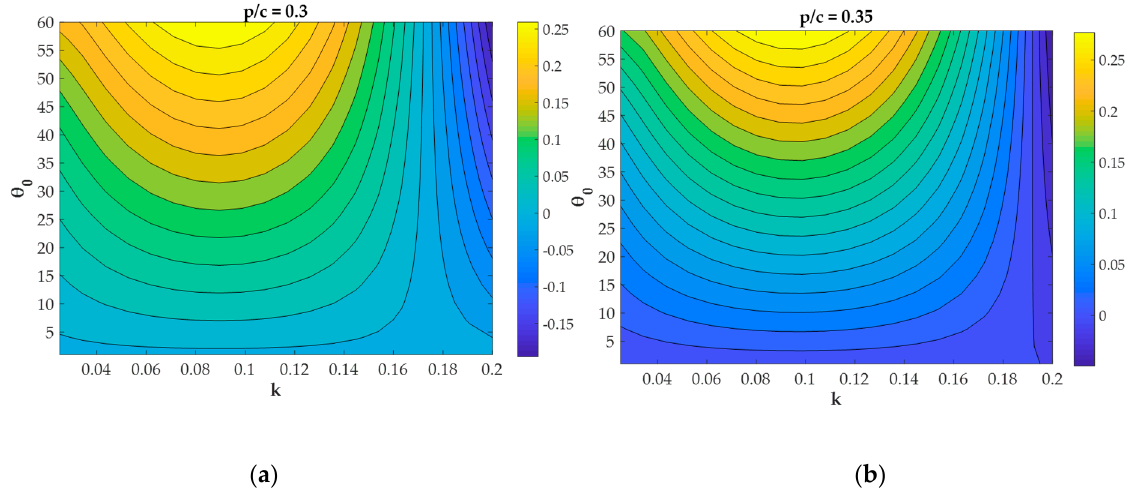
Figure 15. Comparative presentation of calculated performance of the studied device as a function of reduced frequency k = (0.025 − 2) and pitching amplitude θ 0 when the pivot axis is located ( a ) at p / c = 0.3 (left) and ( b ) p / c = 0.